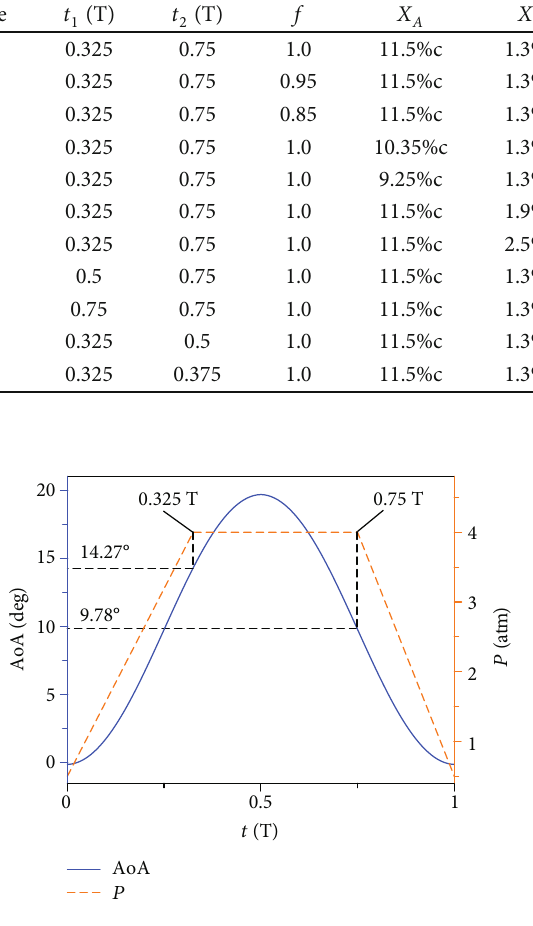
Figure 10: Control laws of in fl ation and de fl ation in Case